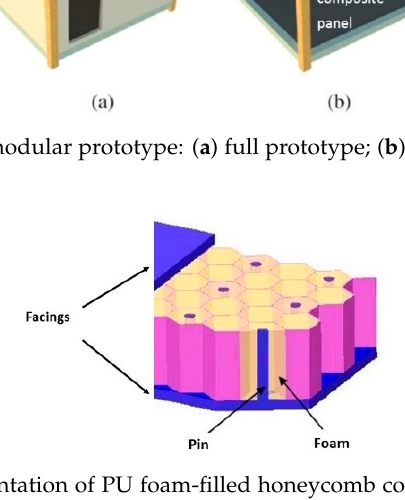
Figure 13. Schematic of the modular prototype: ( a ) full prototype; ( b ) prototype without walls and roof. Adapted from [56].